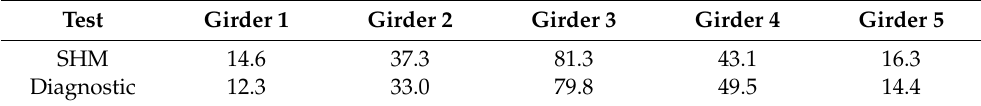
Table 3. Measured strain ( µε